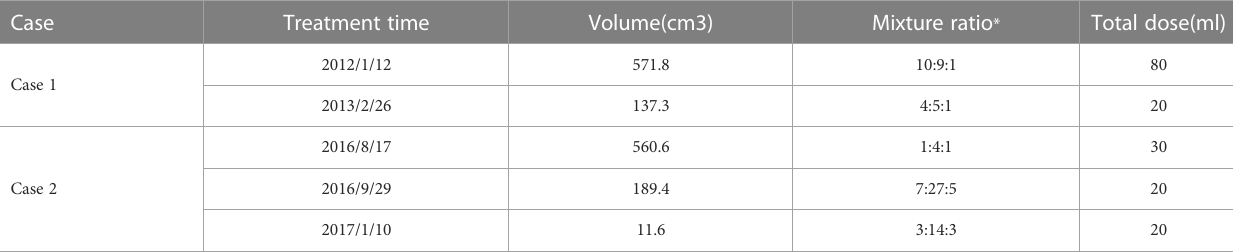
TABLE 1 The chemotherapy ablation